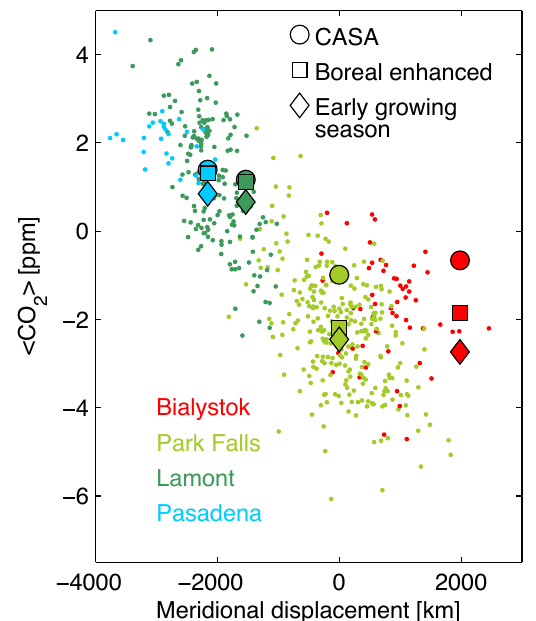
Fig. 9. July–August h CO 2 i 0 from four Northern Hemisphere TC- CON sites plotted against its meridional displacement relative to Park Falls, determined from variations in θ (small circles). A pos- itive meridional displacement indicates a northerly airmass. Also plotted are the July–August mean h CO 2 i for TCCON sites from three AM2 simulations with modified NEE. The h CO 2 i values plot- ted are referenced to the h CO 2 i at Lauder, New Zealand. h CO 2 i from a simulation using CASA NEE (large circles) underestimates the north-south gradient among the TCCON sites. Amplified boreal fluxes (squares) and amplified boreal fluxes with an early growing season onset (diamonds) better capture the north-south gradient dur- ing